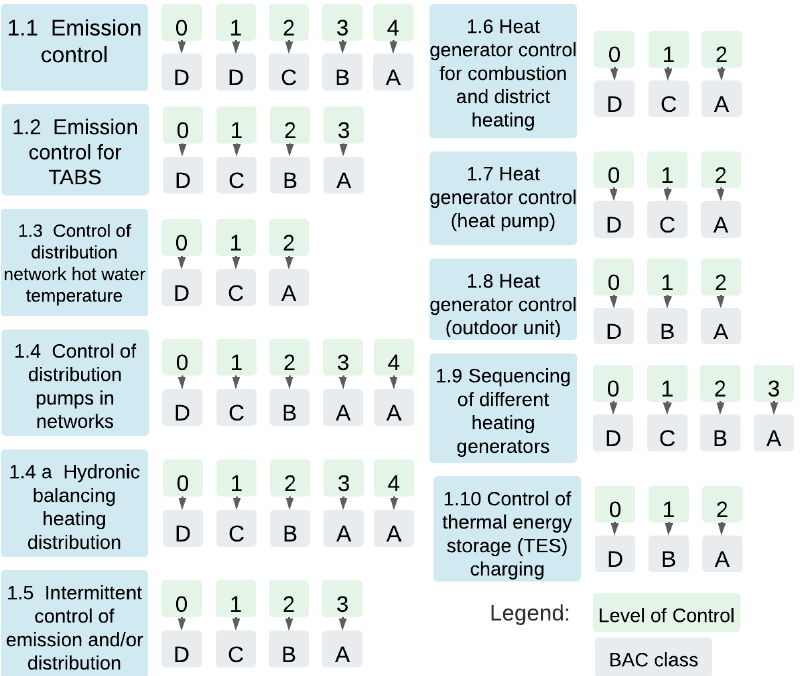
Figure 3. The 11 heating systems, their available control levels, and the reflective BACS efficiency class. Adapted from ISO 52120 ‐ 1:2022 [8].